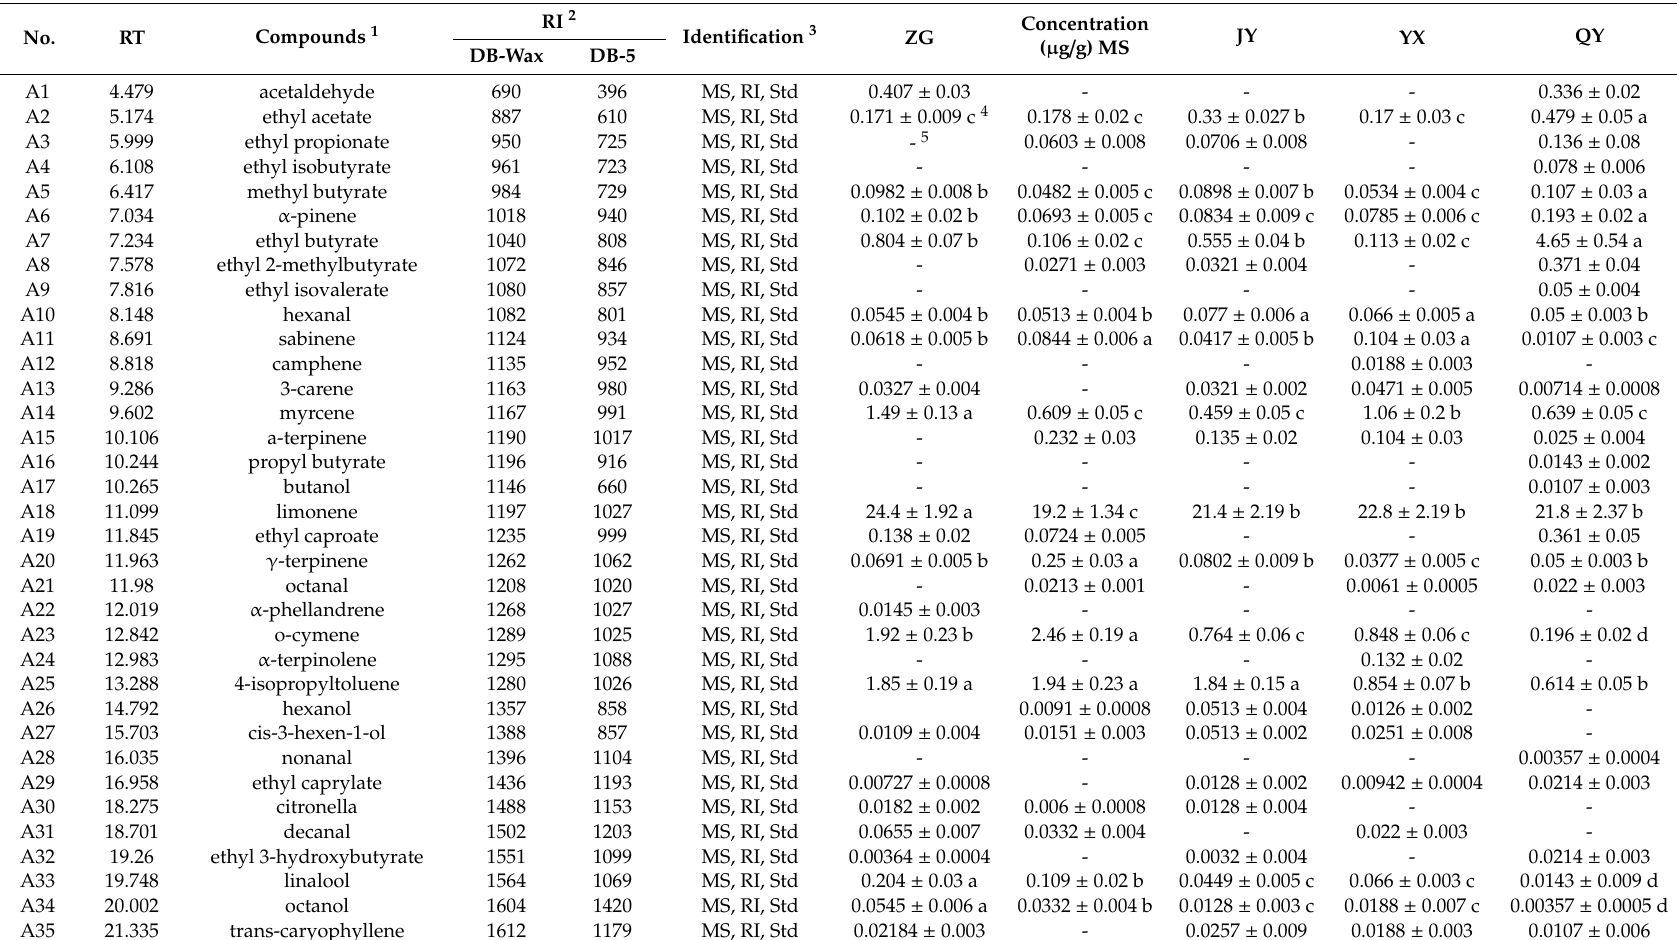
Table 1. Identification and quantification of volatile compounds in the sweet orange juices by